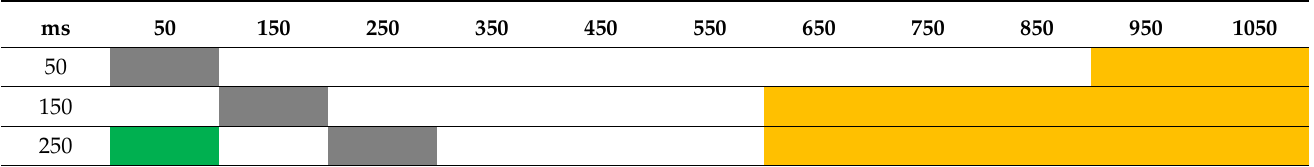
Table A3. Statistical significance between window sizes for ENV algorithm. Green indicates statisti- cally significant difference ( p < 0.05; Bonferroni-corrected) for the RMSE metric, and orange indicates significant difference ( p < 0.05; Bonferroni-corrected) for the cross-correlation metric. Grey indicates diagonal